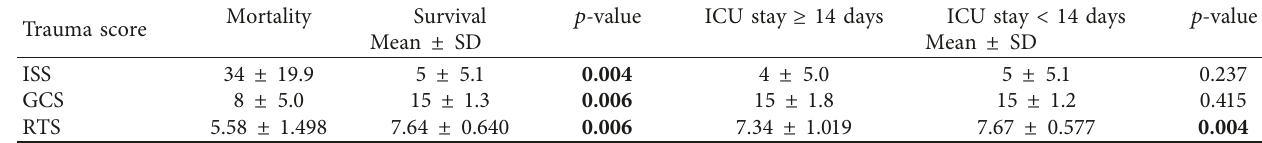
Table 2: Comparison of trauma scores in different groups of mortality and prolonged ICU stay.